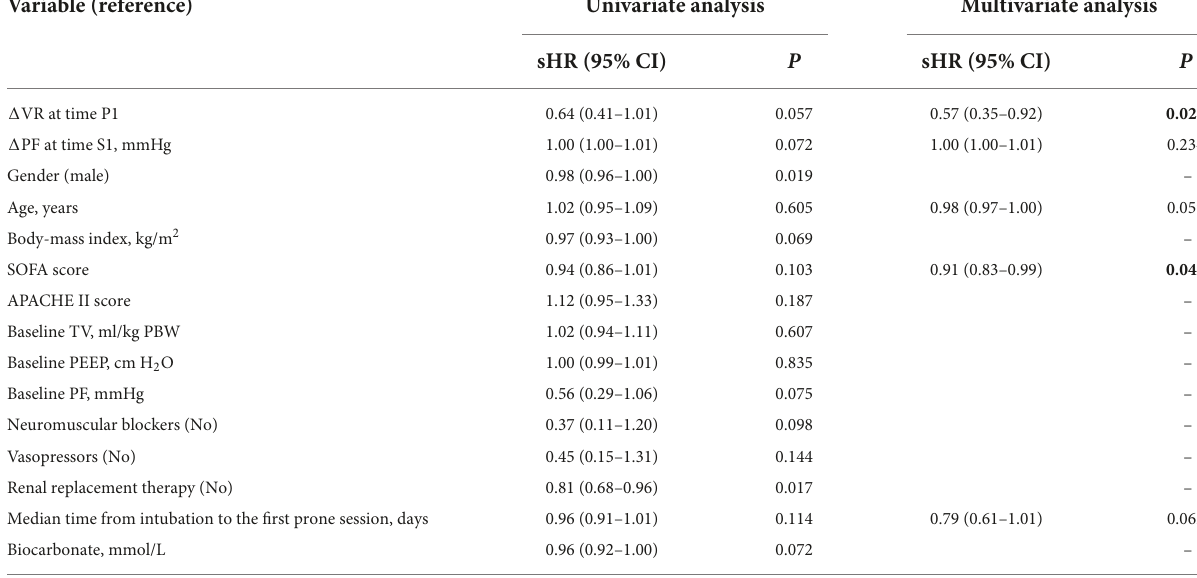
TABLE 3 Competing-risk regression model for predicting liberation from mechanical ventilation at day 28. Variable